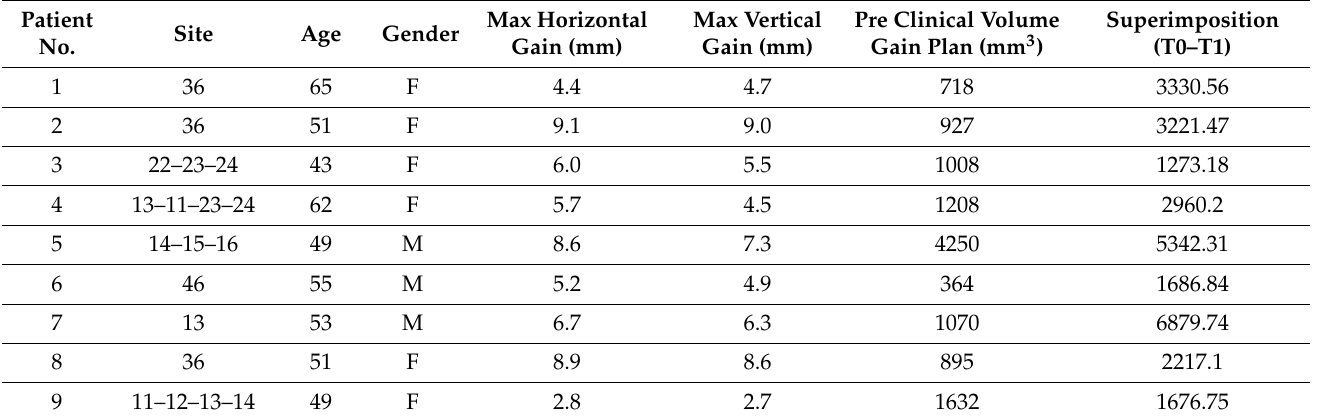
Table 1. Distribution of the bone defects and maximum vertical/horizontal/volume bone gain re- covered through measurements on CTCB.